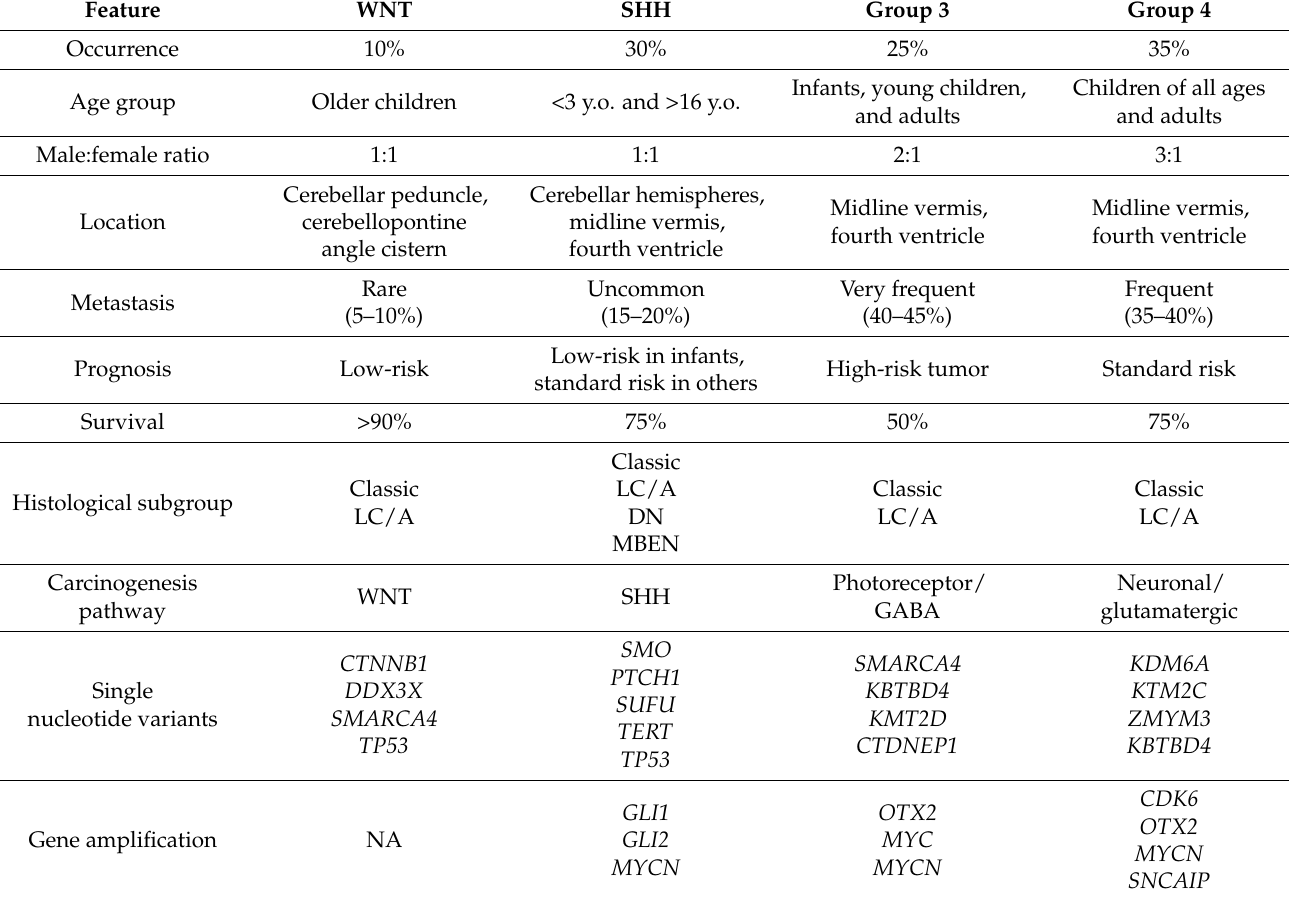
Table 1. Clinical, histological, and molecular characteristics of medulloblastoma subtypes